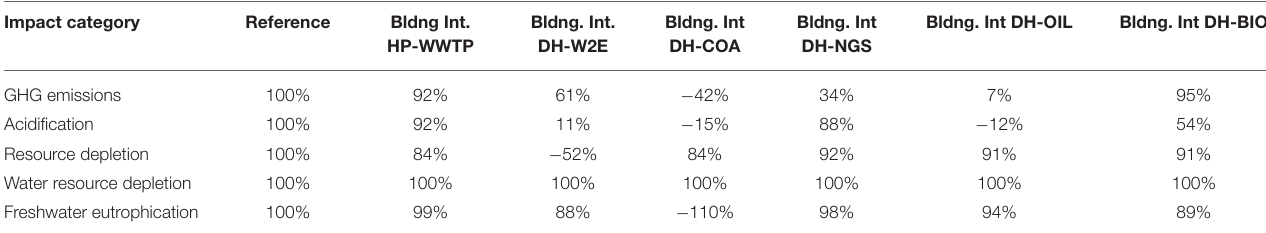
TABLE 3 | Comparison of the environmental impacts compared to the reference